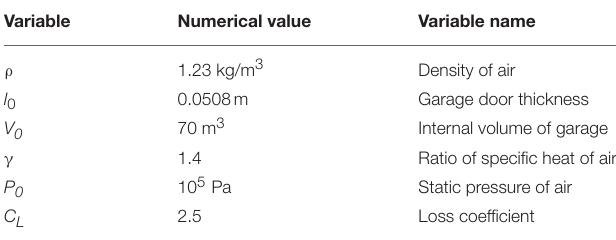
TABLE 3 | Values of constant variables related to SDE and MDE equations.